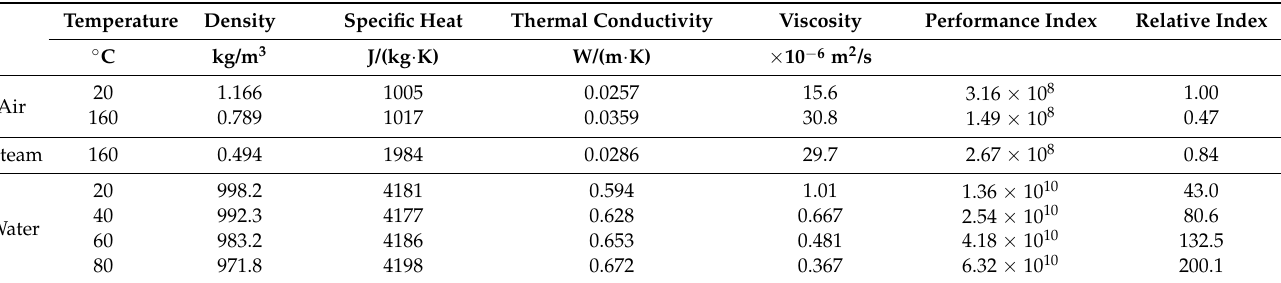
Table 1. Fluid properties and heat transfer performance